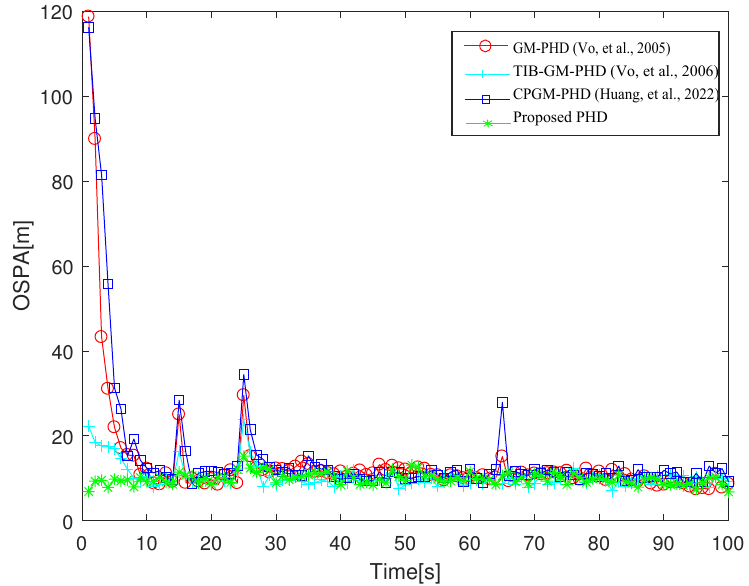
Figure 6. Comparison of OSPA distance between GM-PHD, TIB-GM-PHD, CPGM-PHD and Pro- posed PHD (The numbers in brackets represent references to various PHD methods).